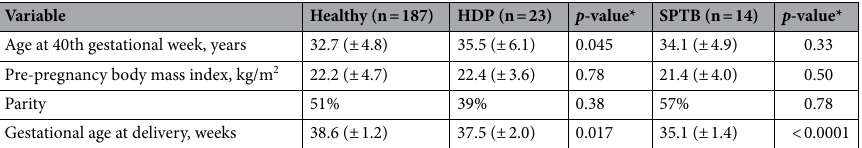
Table 1. Clinical characteristics of pregnant women in this study. *Categorical or continuous variables were compared between the healthy group and either HDP or SPTB groups using Fisher’s exact test or Welch’s t-test, respectively. Regarding gestational age at delivery, significant differences ( p < 0.05) were observed using the Mann–Whitney U test. Data are presented as the mean ±